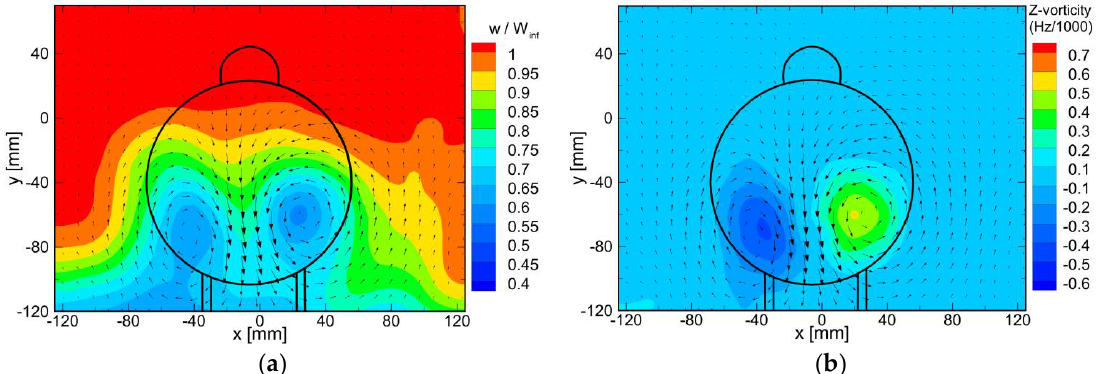
Figure 3. Time-averaged streamwise velocity component ( a ) and streamwise vorticity component ( b ) at z/D = 2.